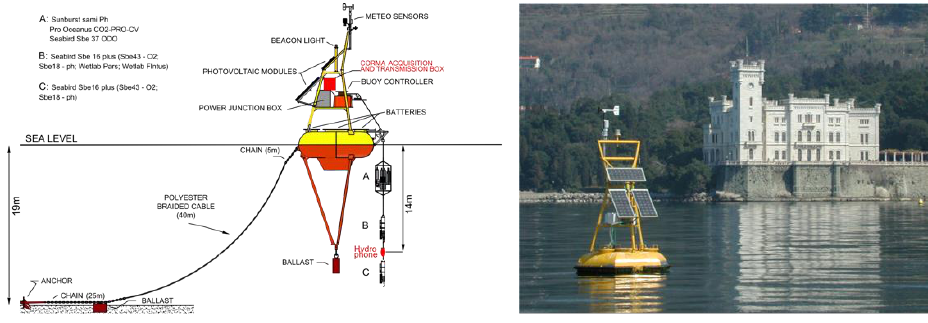
Figure 2. The observatory platform.